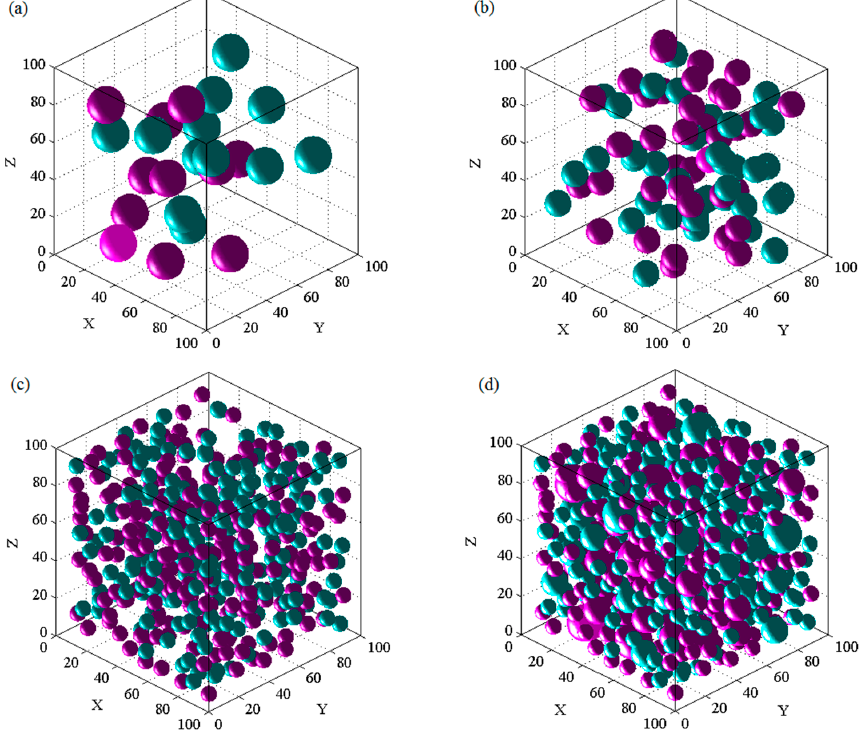
Figure 6. 3D Random aggregate model of recycled aggregate concrete (RAC). ( a ) The radius is 8.75 mm; ( b ) the radius is 6.25 mm; and ( c ) the radius is 3.75 mm; ( d ) All aggregates.